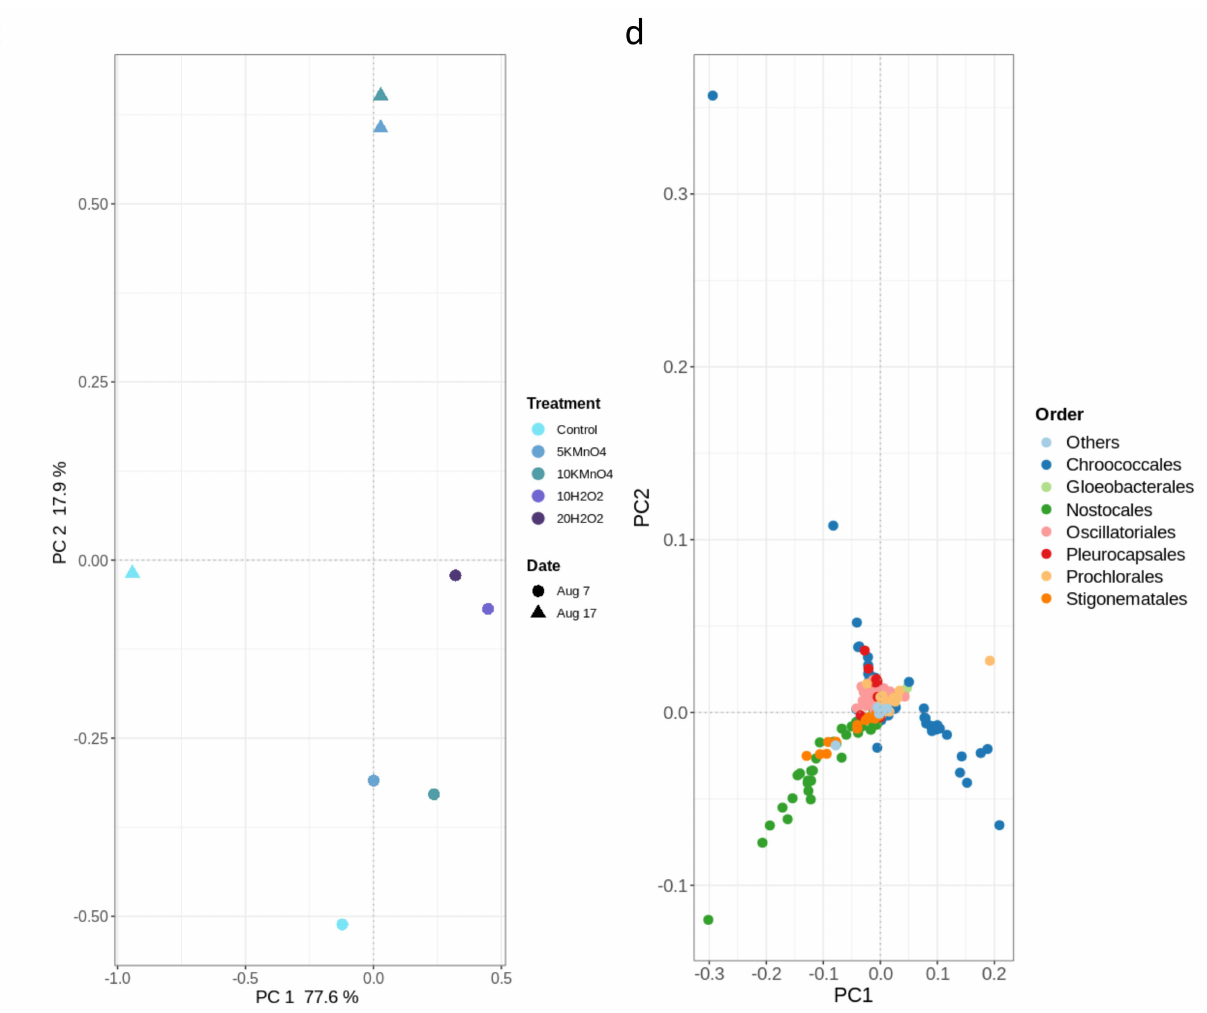
Figure 6. Principal component analysis (PCA) of ( a ) Microbial communities, ( b ) Microbial/cyanobacterial communities grouped at the phylum and order levels, ( c ) Cyanobacterial communities, ( d ) Cyanobacterial species grouped at the order level on 7 and 17 August in the laboratory oxidation. The relative CT significantly affected microbial communities ( p <